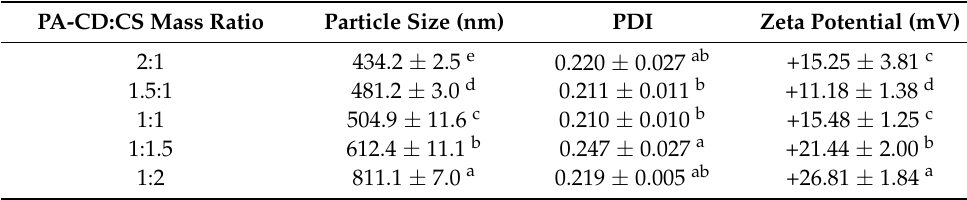
Table 2. Particle size and zeta potential of CS-PA-CD nanoparticles.